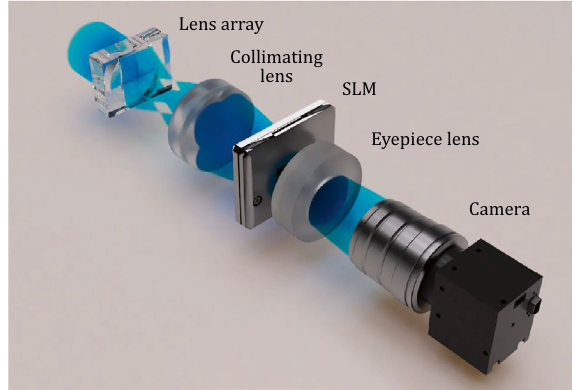
Figure 1. Schematic diagram of an implemented holographic near-eye display with expanded eyebox. A mutually coherent multi-directional wave generator is realized by using a lens array and a collimating lens. An eyepiece lens is placed behind the SLM to form an expanded